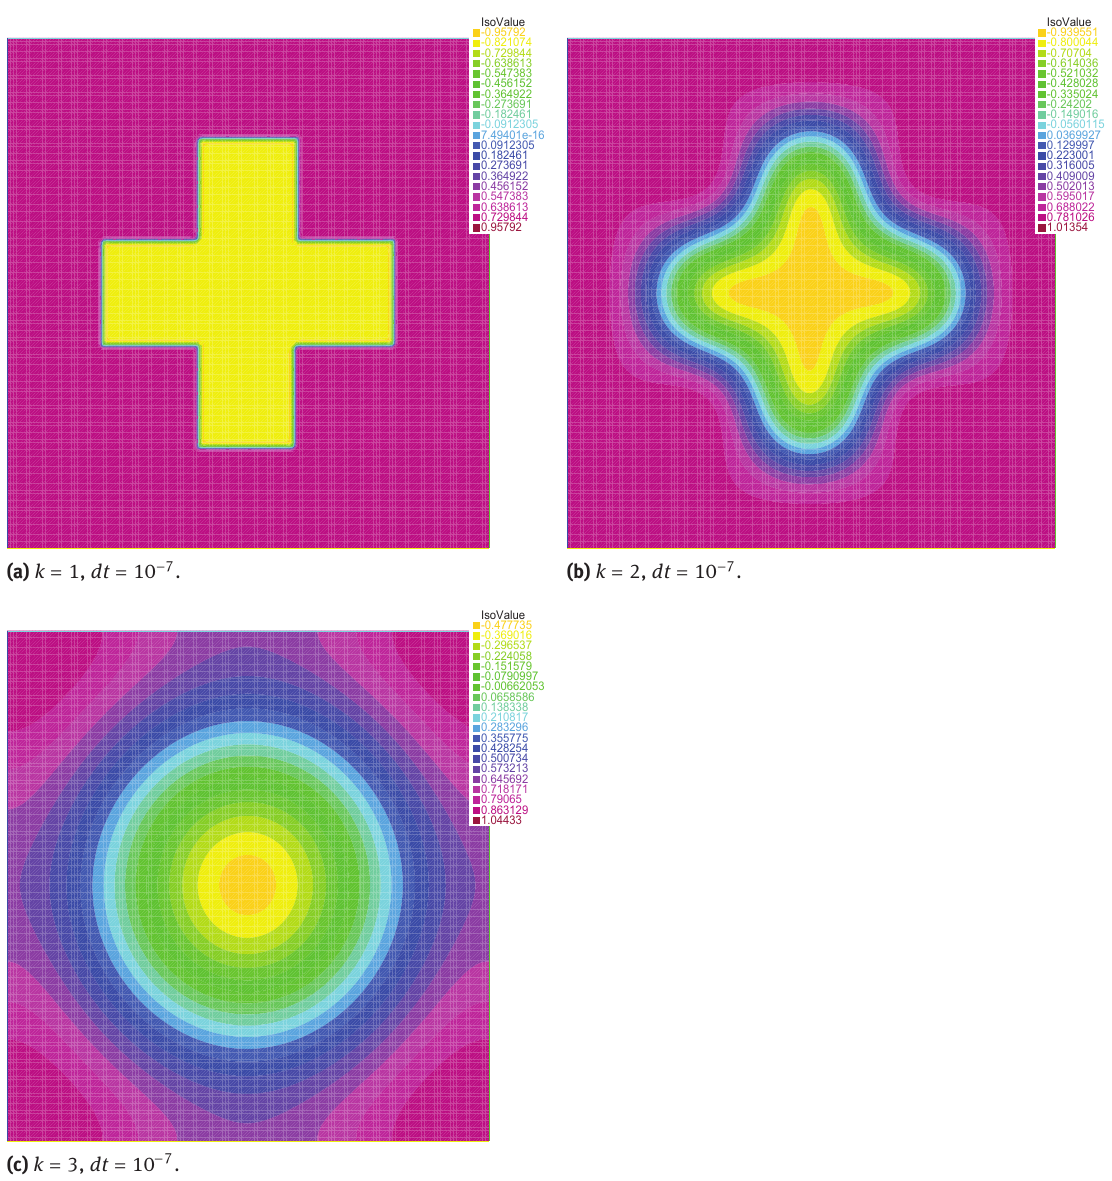
Figure 3: Results after 40 iterations with different values of k and with the same time